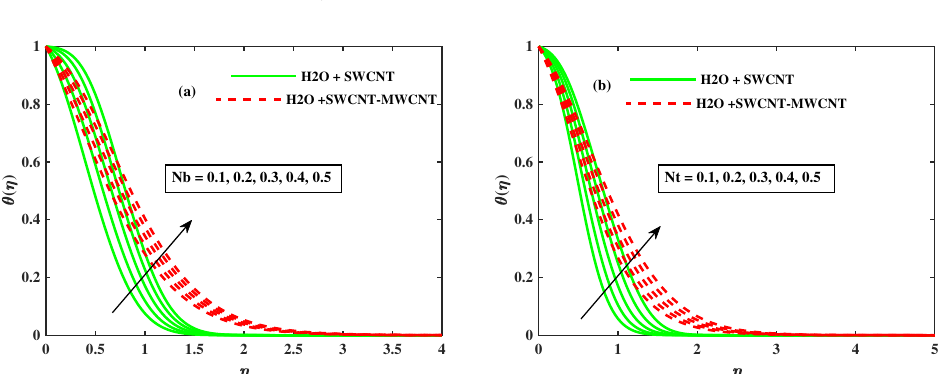
Figure 4. Effect of λ and M on θ ( η ) .